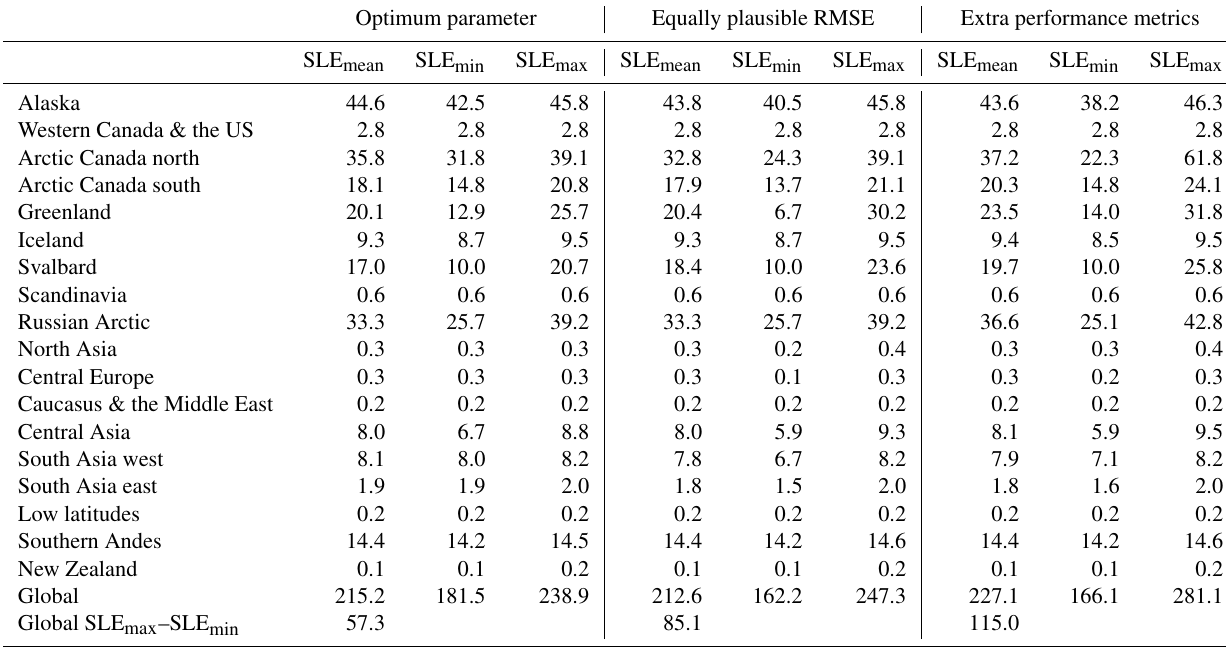
Table 7. Regional ensemble mean, minimum, and maximum volume losses for 2097 in sea level equivalent (mm) when the present-day mass balance is calibrated in different ways. Columns 1–3: mass balance is calibrated by minimising the RMSE. Columns 4–6: mass balance is calibrated using an ensemble of equally plausible RMSE values. Columns 7–9: mass balance is calibrated by minimising the RMSE, minimising the bias, and maximising the correlation